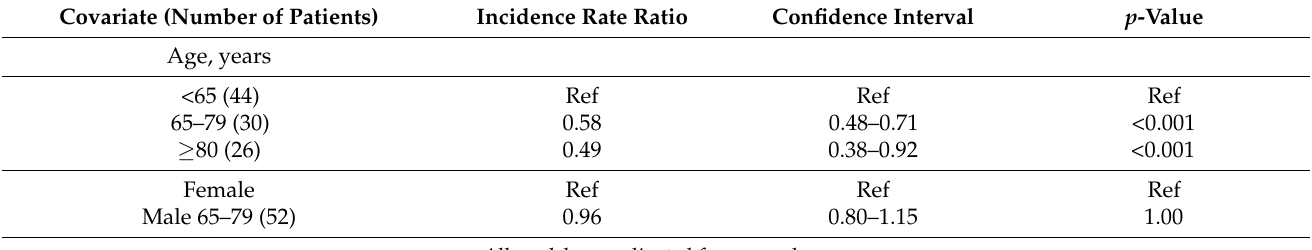
Table 3. Factors associated with prescribing discrepancies between the Shared Medication Record (SMR) and patients actual use of medications.